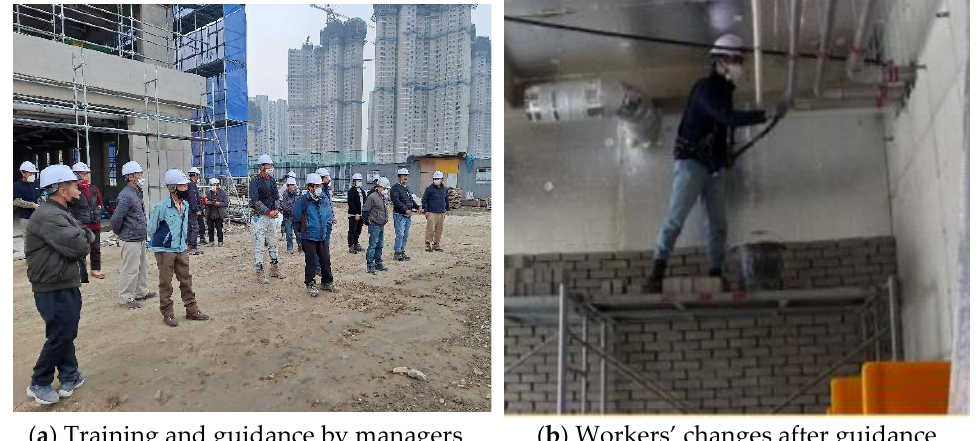
Figure 15. Changes in worker behavior through education and instruction.